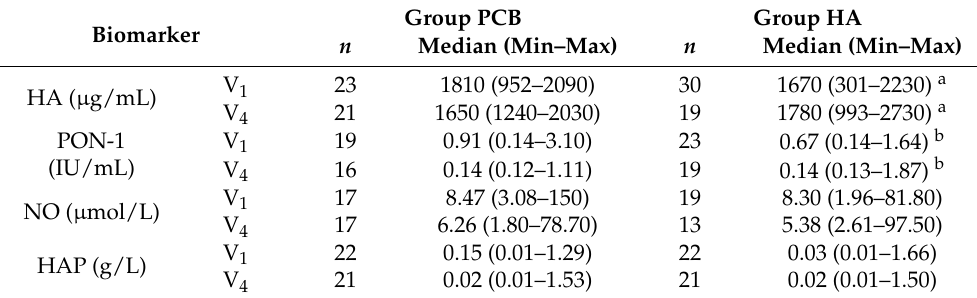
Table 3. Synovial fluid biomarker concentrations in different